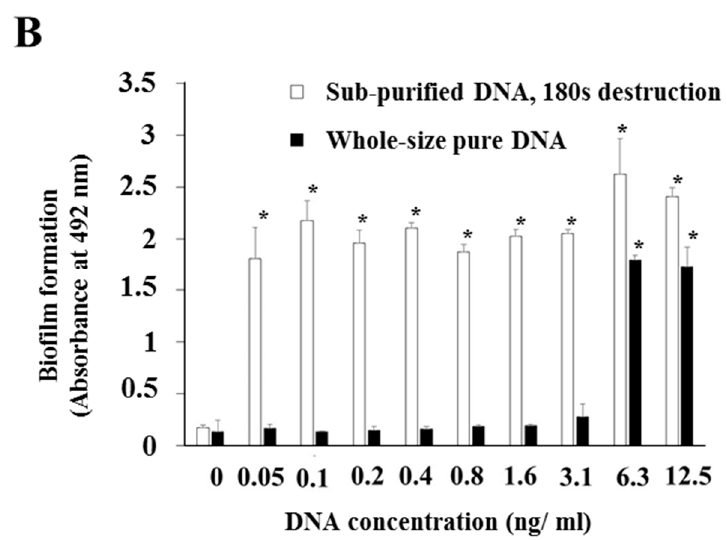
Figure 1. Preparation of various types of DNA. ( A ) Whole-size pure DNA, sub-purified DNAs prepared by beads destruction for 90 (Sub puri DNA 90s) and 180 s (Sub puri DNA 180 s), sub puri DNA 180 s treated with phenol and chloroform (Sub puri DNA 180 s + Phen Chlo), and sub puri DNA 180 s + Phen Chlo treated with proteinase K (sub puri DNA 180 s + Phen Chlo + Pro K) were observed for molecular size and proteins. Left: Polyacrylamide gel after SDS-PAGE analysis using various types of DNA was stained by Coomassie Brilliant Blue (CBB), and Center: Ethidium bromide staining to left gel. Right: Agarose gel after electrophoresis using the same samples was stained by ethidium bromide. M: Protein marker. ( B ) Sub-purified DNAs prepared by beads destruction for 180 (Sub puri DNA 180 s) was used as a DNA with proteins. Biofilm formation of Streptococcus mutans UA159 gtfBC − was quantitatively assessed in conditions with DNA with proteins and pure full size DNA. The data indicate the mean ± standard deviation (SD) of triplicate experiments. The independent experiments were performed three times, with similar results obtained in each. The asterisks indicate a significant difference between the two groups (*: p < 0.01, no DNA vs. DNA).